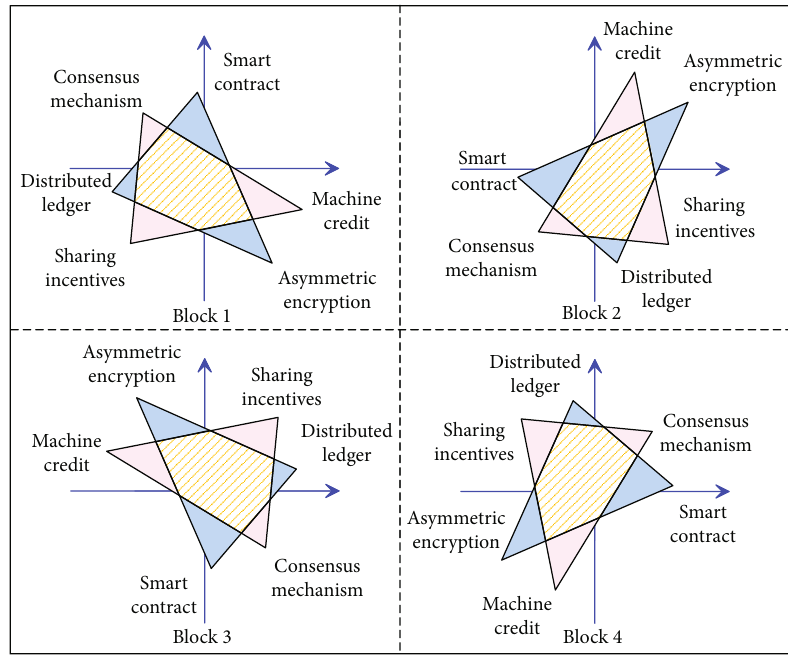
Figure 4: Blockchain-established special machine trust for resource allocation based on blockchain and structured occupational